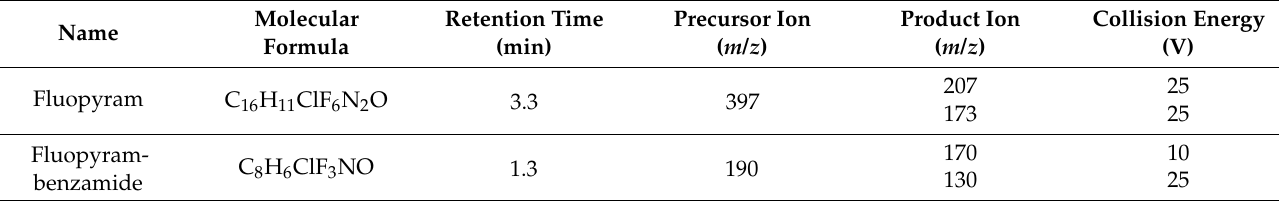
Table 6. Multiple reaction monitoring (MRM)